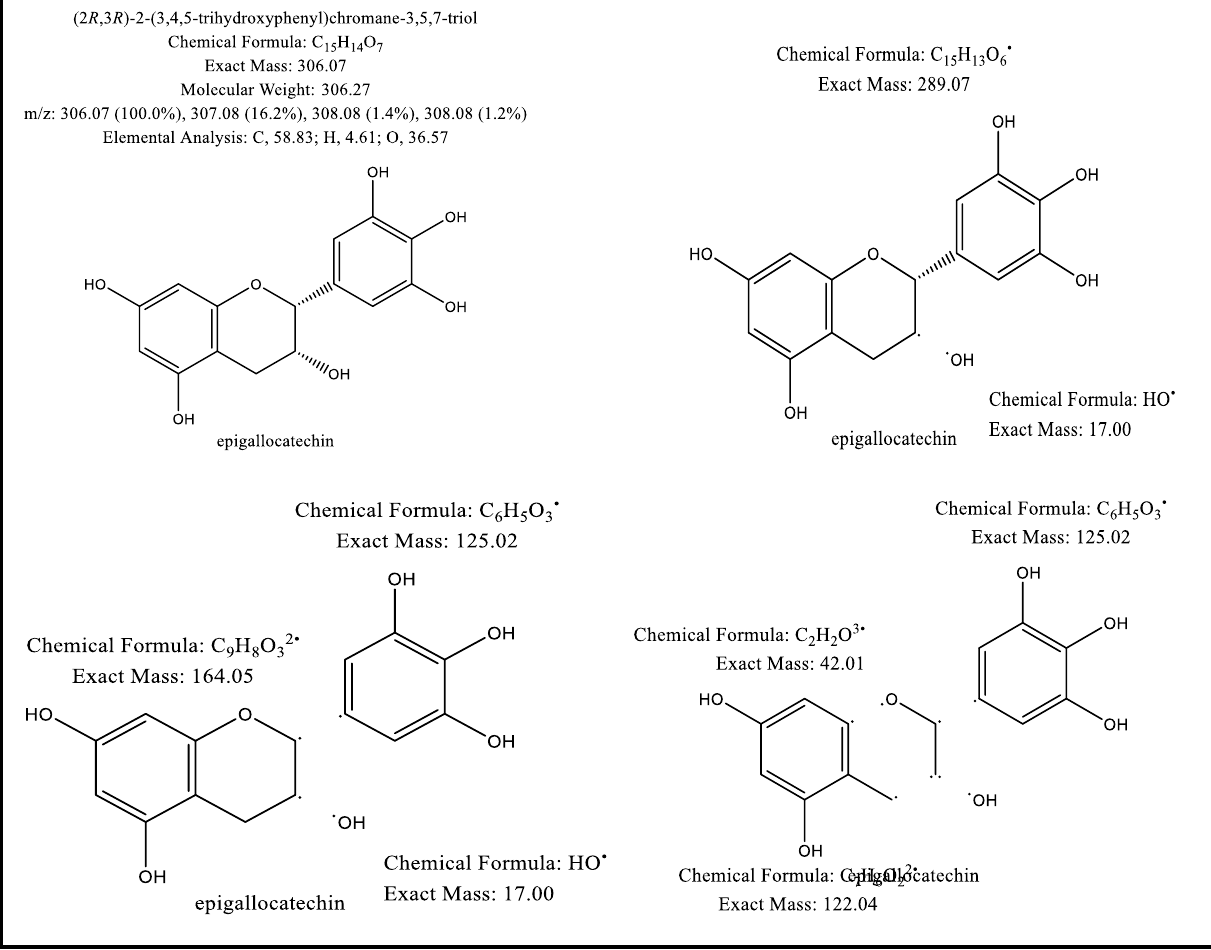
Figure 10. Mass Fragment of Compound I Epigallocatechin Epigallocatechin = 306.27 g/mol M\Z= 306.07